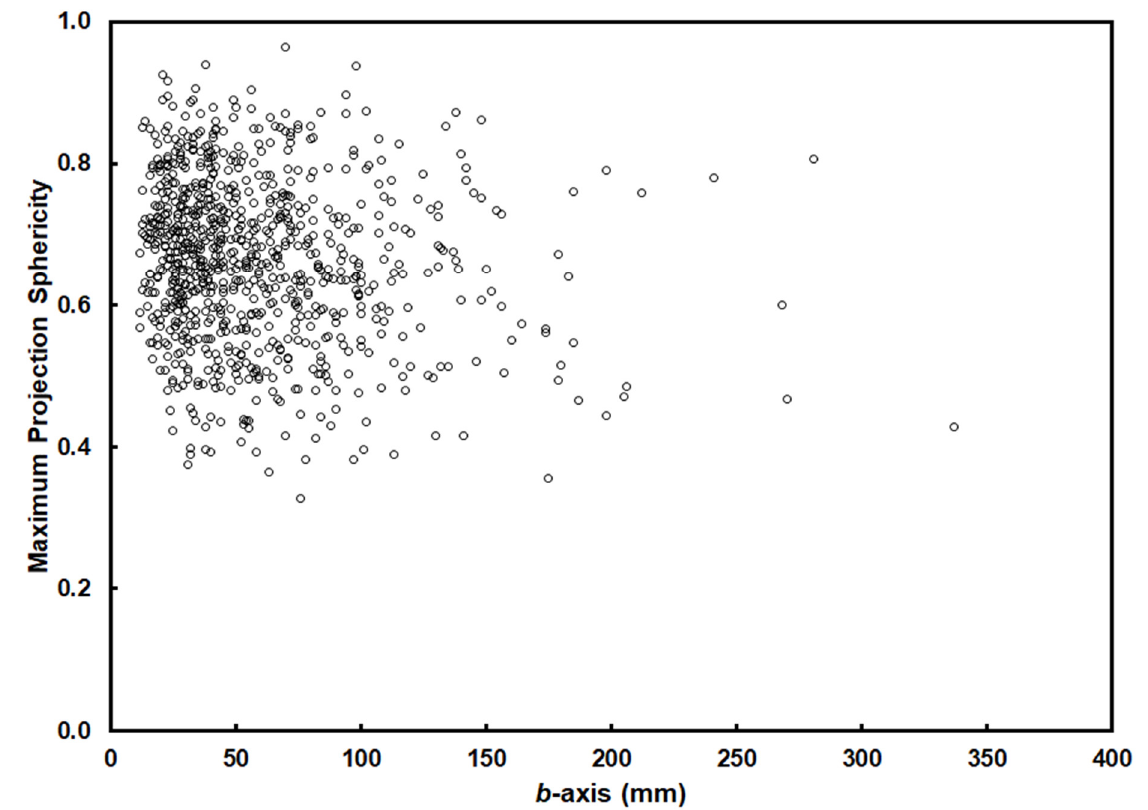
Figure 9. The Maximum Projection Sphericity of fluvial gravels of Navilawa Monzonite from Stations 1–7 along the Sabeto River of western Viti Levu, Fiji as a function of particle b -axis length.